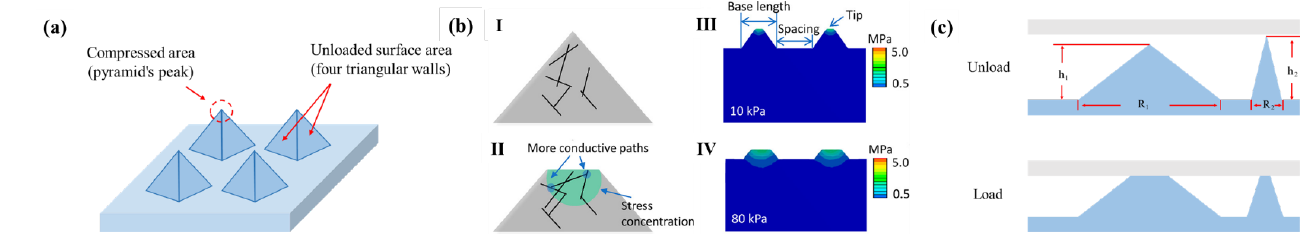
Figure 5. Schematic of ( a ): the definition of shape factor. ( b ): the conductive micro pyramids ( I ) without pressure and ( II ) with pressure, ( III ) under low pressure (10 kPa) and ( IV )under high pressure (80 kPa) to show that the stress concentrated at the pyramid tips [43]. ( c ): comparison of microstructure with different shape factors (aspect ratio) before and after load.